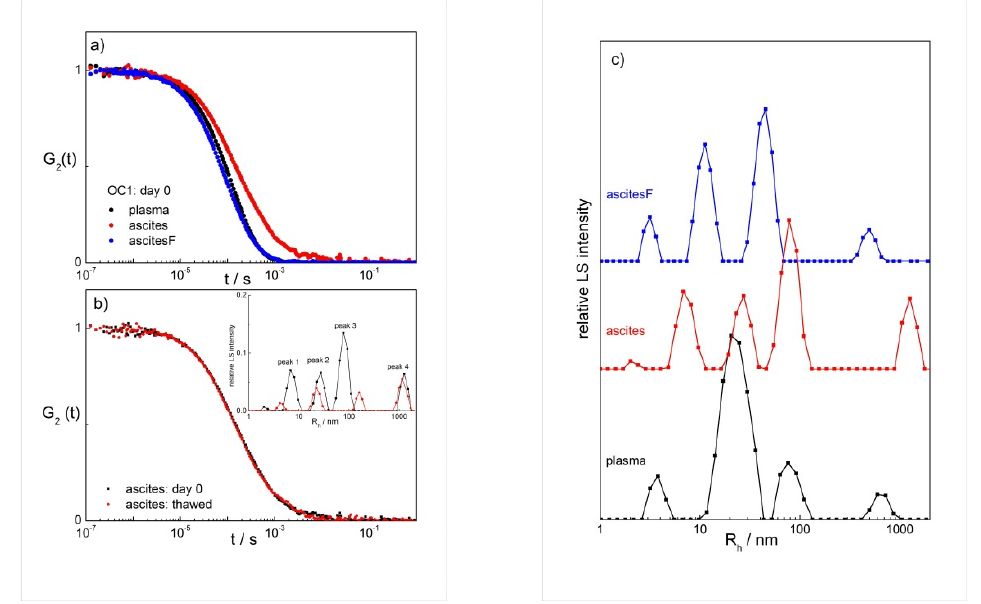
Figure 1. ( a ) The normalized intensity correlation functions ( G 2 (t)) of plasma, ascites, and filtered ascites (ascitesF) measured on the day of sampling (day 0) at θ = 90 ◦ and T = 25 ◦ C; ( b ) the effect of freezing/thawing on G 2 (t) and the calculated distributions of the hydrodynamic radii ( R h ) of particles in ascites (see inset); ( c ) the intensity weighted distributions of the hydrodynamic radii ( R h ) of particles in plasma and both ascites samples. All data are for ovarian cancer patient OC1. The distributions are calculated by considering the viscosity of water at 25 °C ( η o = 0.9 mPa s − 1 ).